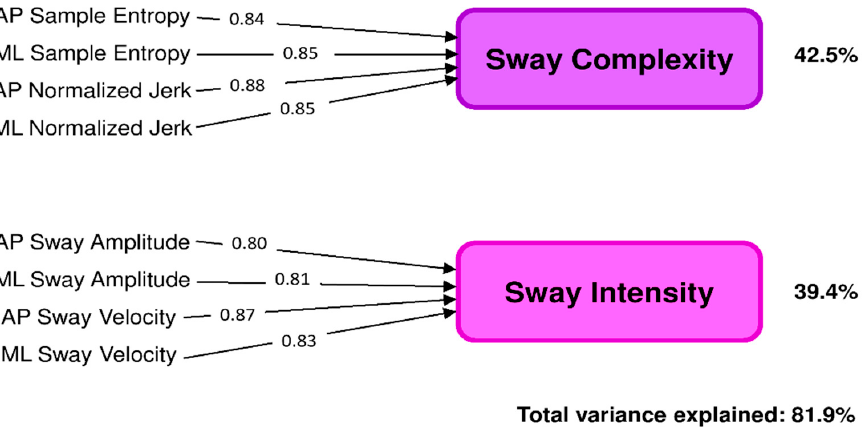
Figure 1. Result of the principal component analysis. Eight wearable-sensor-based variables descriptive of trunk sway during the instrumented modified Romberg test (reported on the left) were reduced to two “latent variables” (principal components) called “sway complexity” and “sway intensity”. Arrows report significant factor loadings (>0.60). The percentage of variance explained by each component and the total variance is given on the right.